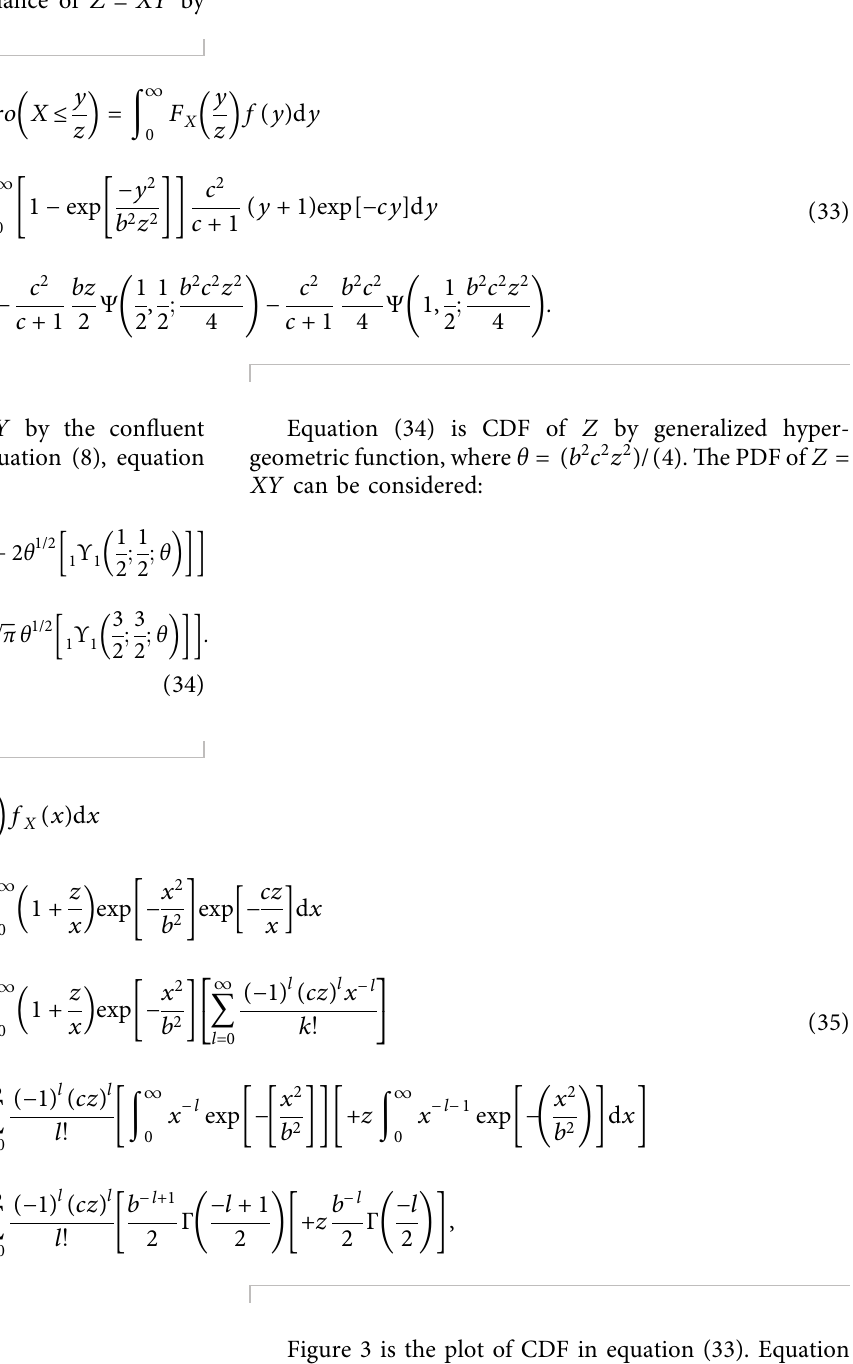
Figure 3 is the plot of CDF in equation (33). Equation (36) is PDF of Z by gamma function of the negative integer